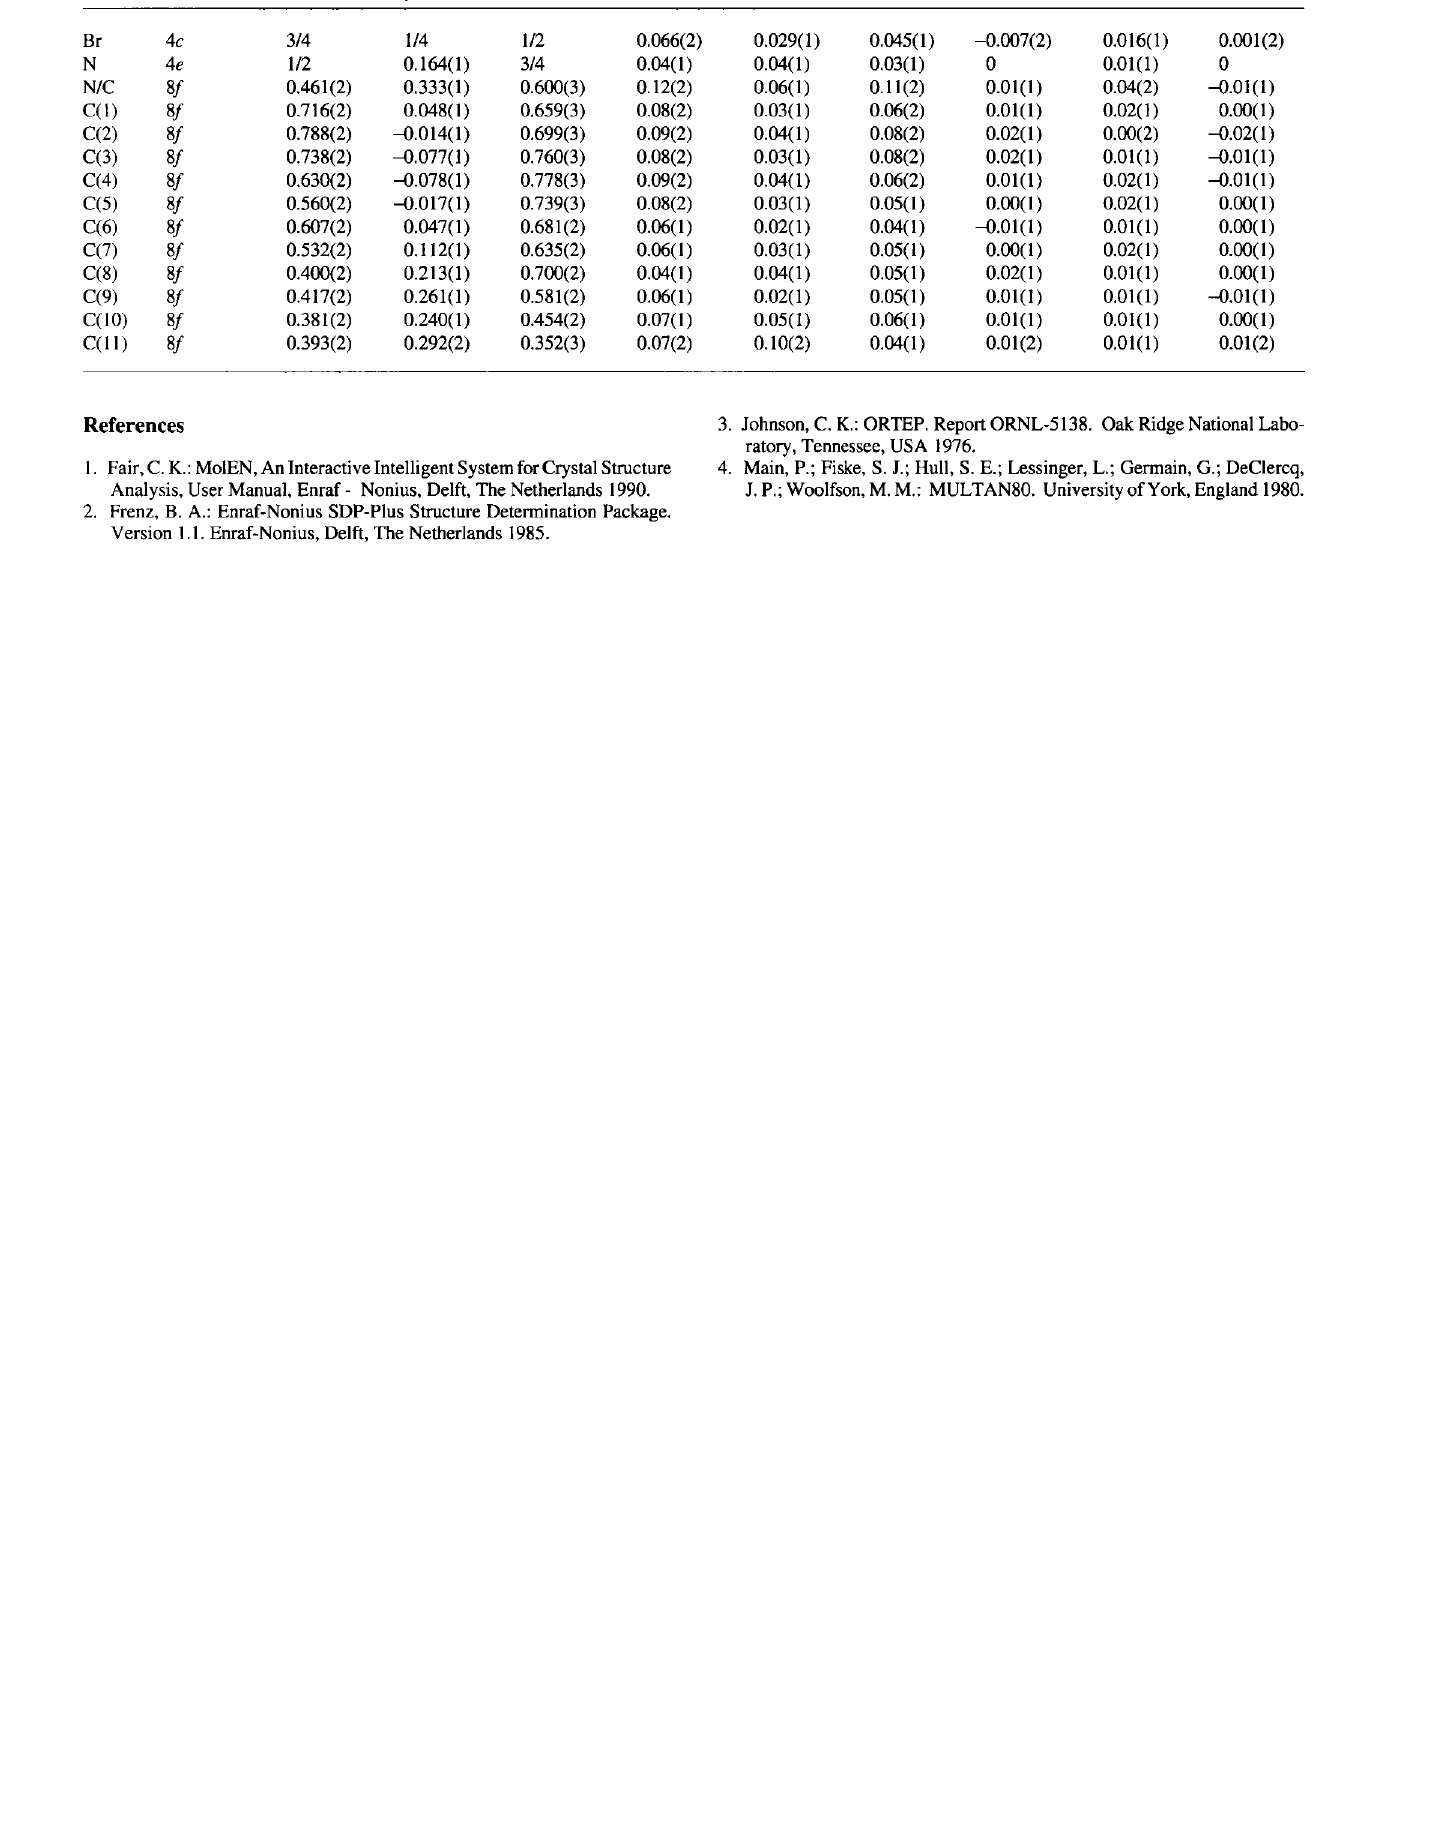
Table 3. Atomic coordinates and displacement parameters (in Ä 2